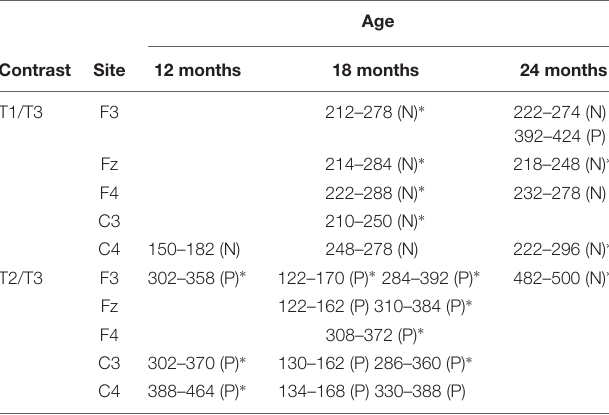
TABLE 1 | The intervals of positive (P) and negative (N) clusters for each contrast on each site in 12-, 18-, and 24-month-old groups.